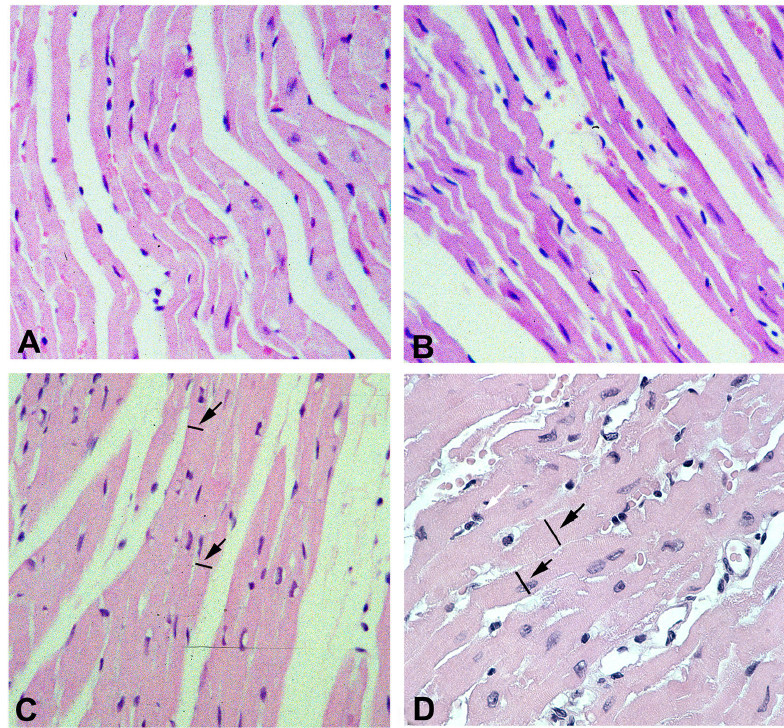
Figure 2. Conventional histologic analysis of WT and NTT-MMP-2 transgenic hearts at four months and six months of age. Hematoxylin/eosin-stained sections of left ventricular free walls from four month old WT (panel A) and NTT-MMP-2 transgenic mice (panel B) demonstrate normal cardiomyocyte structure and organization. By six months of age, the transgenic hearts (cf. panel C, WT and panel D, TG) have developed cardiomyocyte hypertrophy (arrows point out cross-sectional markers) and a loss of cardiomyocyte organization